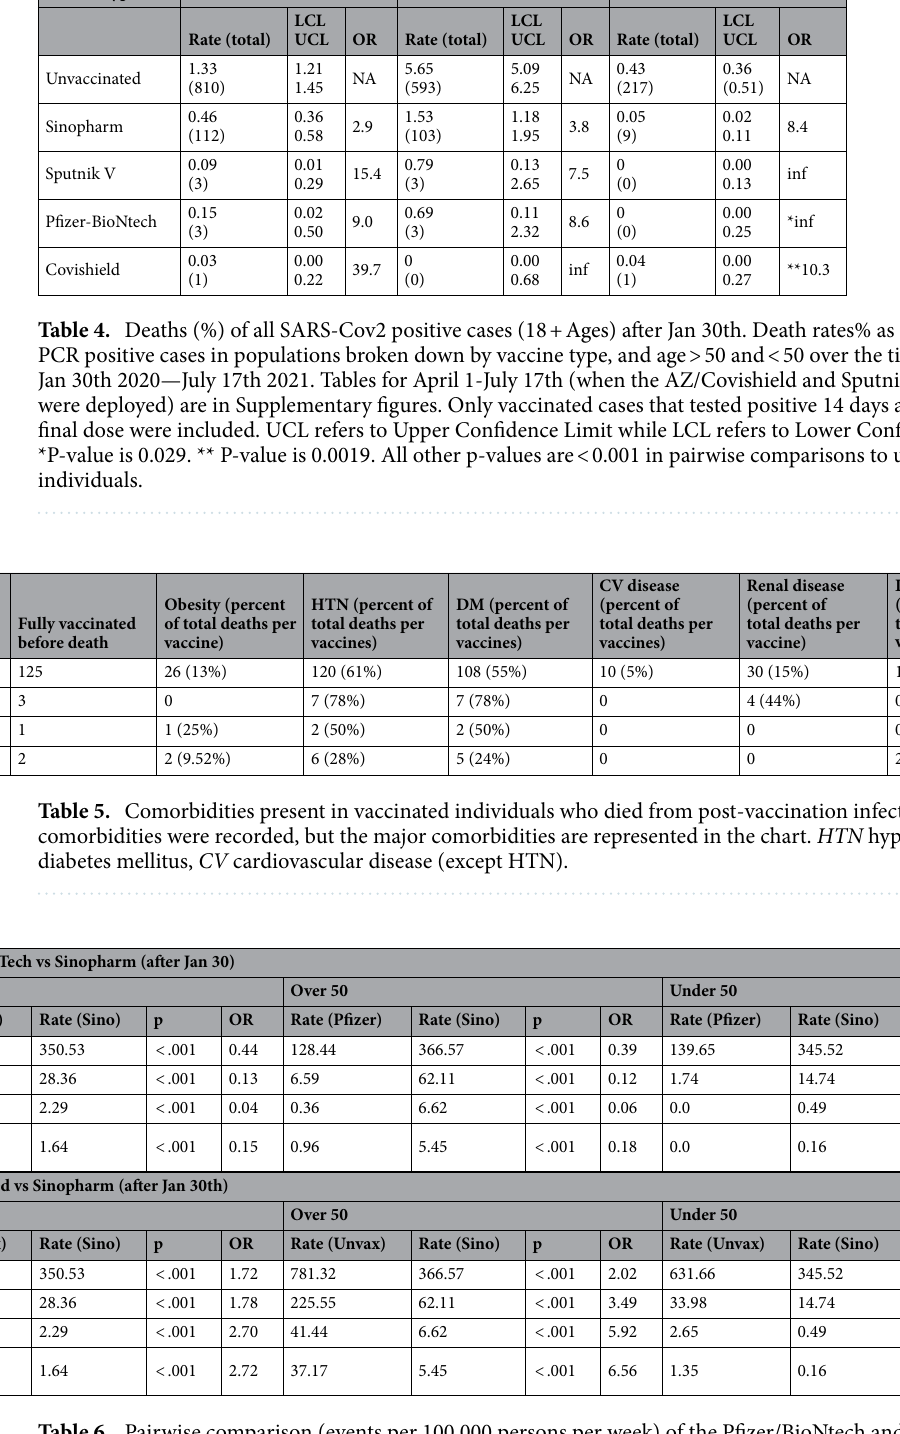
Table 6. Pairwise comparison (events per 100,000 persons per week) of the Pfizer/BioNtech and the Sinopharm vaccines (a) and Unvaccinated versus Sinopharm vaccinated individuals (b) in age cohorts > 50 and < 50 showing the rates of infections, hospitalisations, ICU admissions and deaths, p values and odds ratios. All rates are events per 100,000 of the sample population. Note that the p values for the comparison were all < 0.01, except ICU admissions in “under 50” cohort and deaths for the Sinopharm versus Pfizer comparison and Sinopharm versus Unvaccinated comparison (in bold). Note that early recipients of Sinopharm (Dec 9th– Jan 30th) were eliminated from the analysis, since Pfizer vaccination began on Jan 30th. Comparisons between vaccines between April 1–July 17th (when AZ/Covishield and Sputnik V were deployed) are in Supplementary